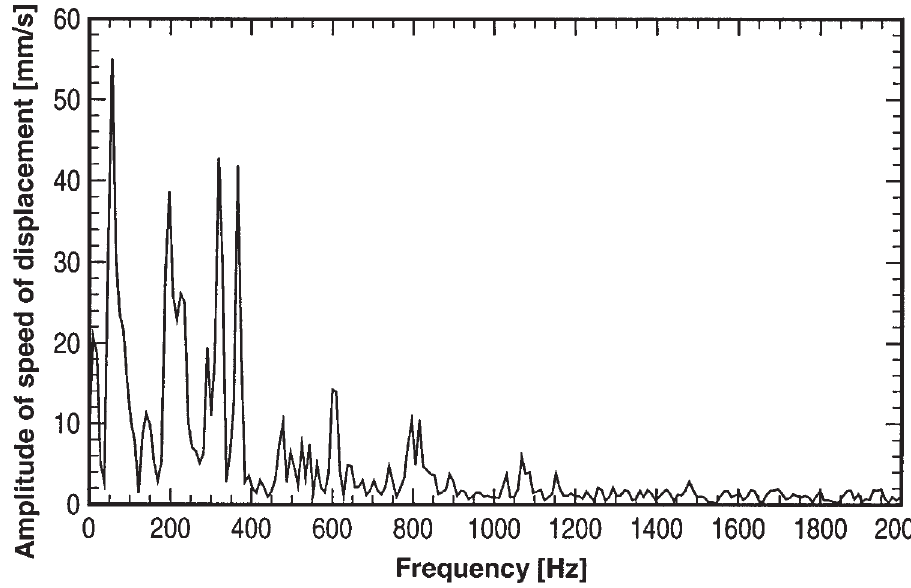
Fig. 11. Frequency spectrum in the low frequency range. Peaks can be associated with natural frequencies of bending and axial